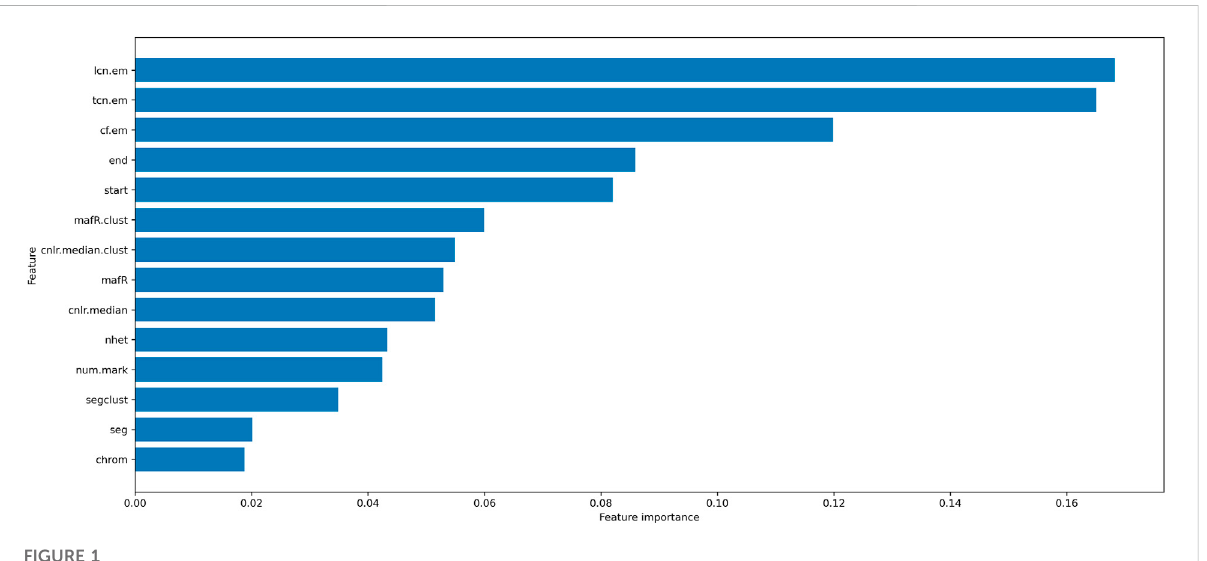
FIGURE 1 The importance of LOH